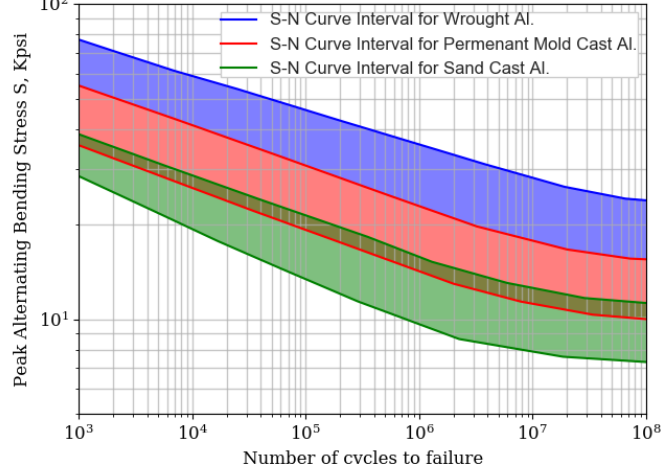
Figure 2a: A hypothetical S-N curve for steels, the endurance limit has a ‘knee’ at S FL . The stress amplitude and cycles are in log-log scales [2].